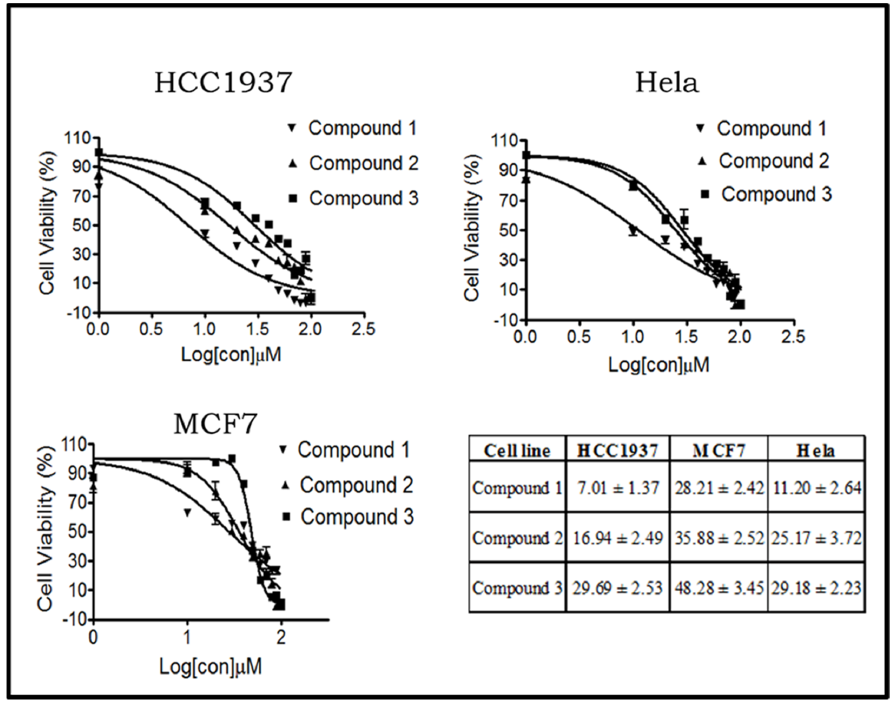
Figure 1. Cytotoxic effect of compounds 1 – 3 against breast (HCC1937 and MCF7) and cervical (HeLa) cancer cells. The cell lines were treated with increasing concentrations (1–100 µM) of compounds 1 – 3 . Cell viability was assessed by MTT assay after 48 h of treatment. The table shows IC 50 values (mean ± SD) obtained from three independent determinations, each performed in quadruplicate. A control with solvent only (0.01% ( v / v ) DMSO) showed no effect on viability remaining at 100% (not shown).